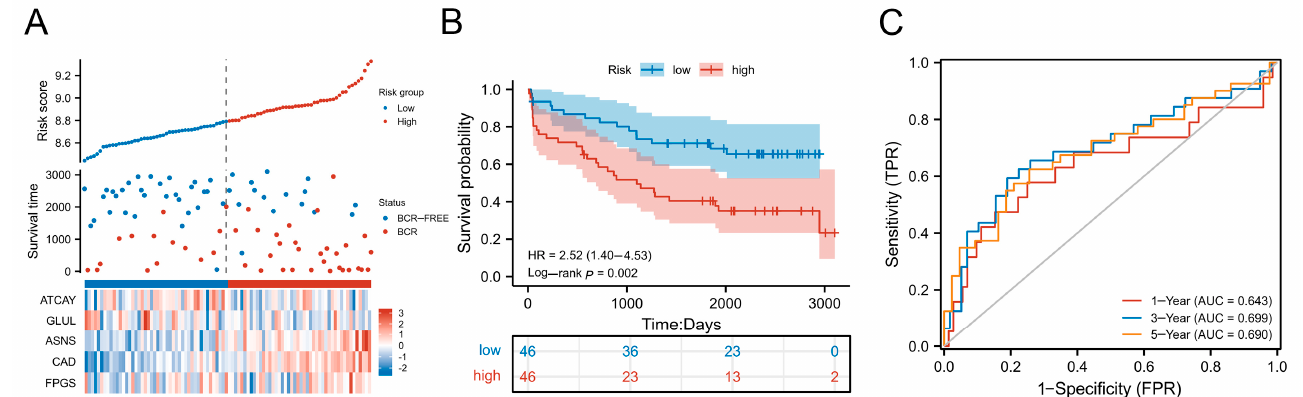
Figure 4. Verification of risk scoring model by external cohorts derived from the GEO dataset (GSE70769). ( A ) The distribution of the five-gene risk score, the five-gene expression differences in high and low risk groups, and survival status for each patient. ( B ) Kaplan–Meier curve of BCRFS in high-risk and low-risk group. ( C ) The 1-year, 3-year and 5-year time-dependent ROC curves of BCRFS in validation datasets.